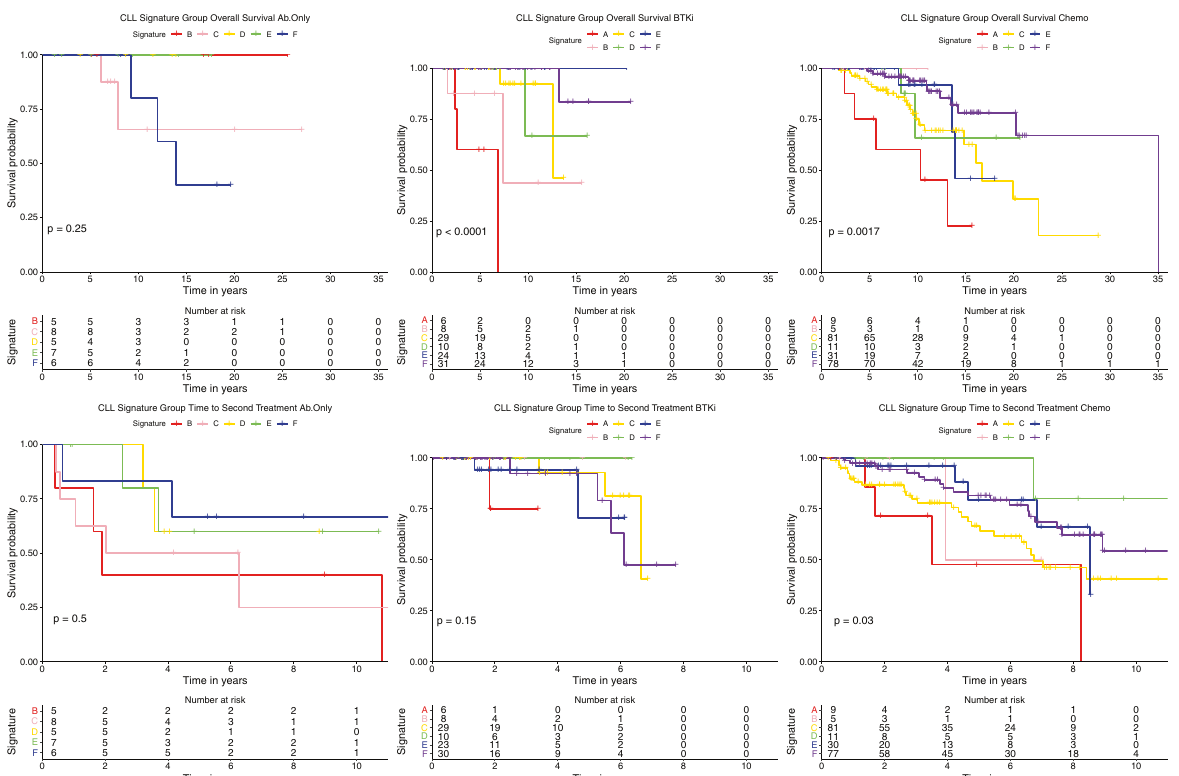
Fig. 5 Signature group therapy responses. Signature Group OS (top panel) and TTST (bottom panel) were evaluated by therapy class (Antibody, Chemotherapy, and BTKi). For chemotherapy, signatures B-F would be good candidates whereas signatures A and C would not as they had shorter OS (top) and TTST (bottom). In regard to the BTKi class, most signature groups respond well (B-F). As the Antibody only group was small, it is dif fi cult to make conclusions. Further studies are necessary for the signature groups responses to Ab therapy